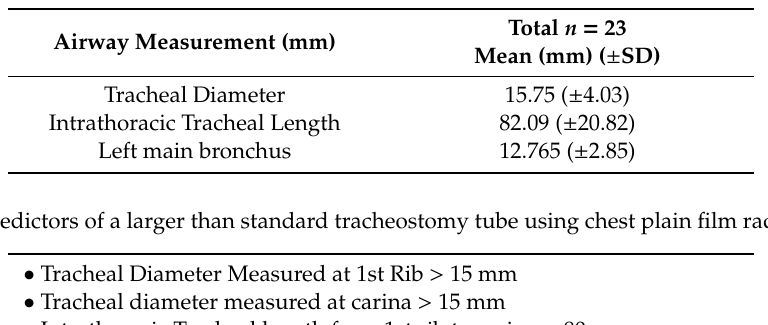
Table 2. Airway dimensions.